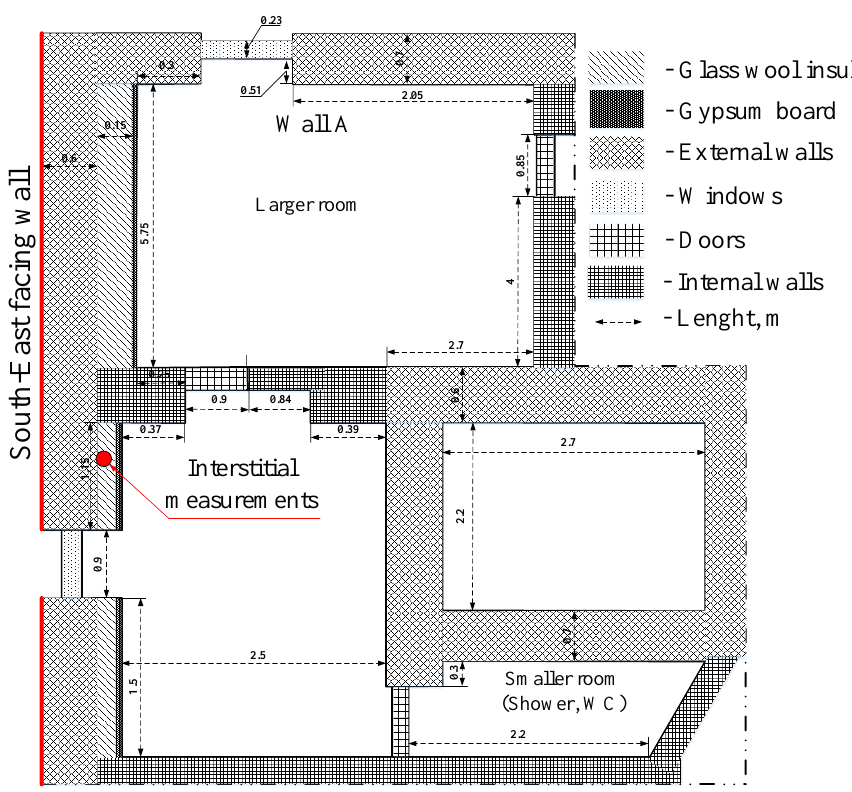
Fig. 2. Cross section of monitored wall with measurement